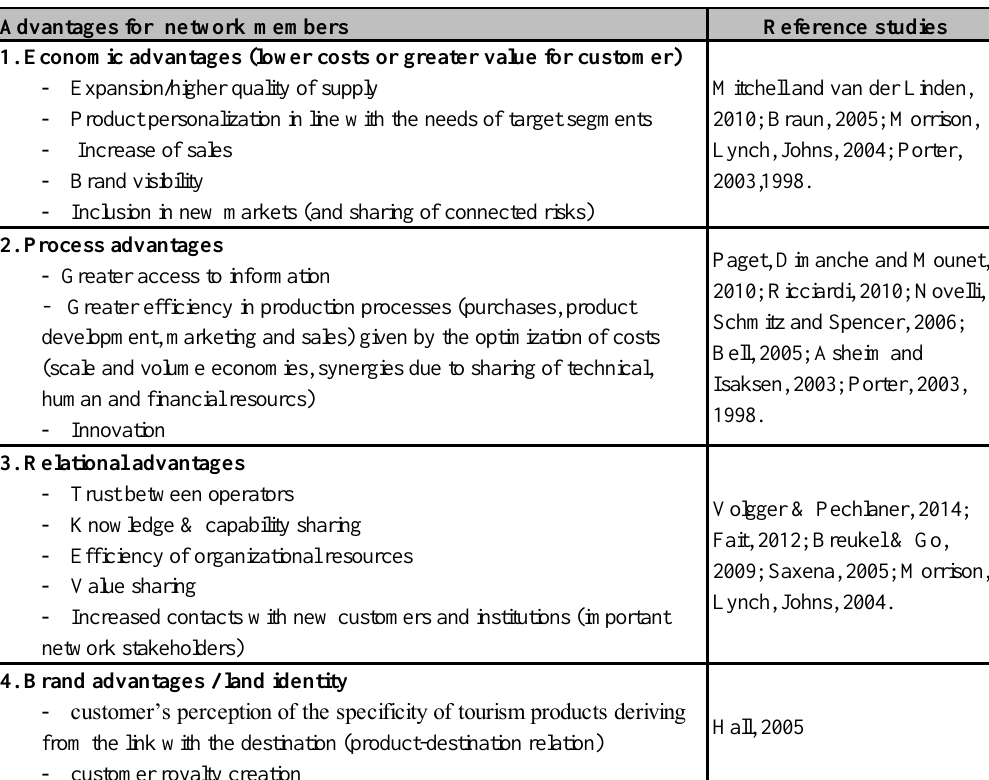
Table 1: Network Advantages for